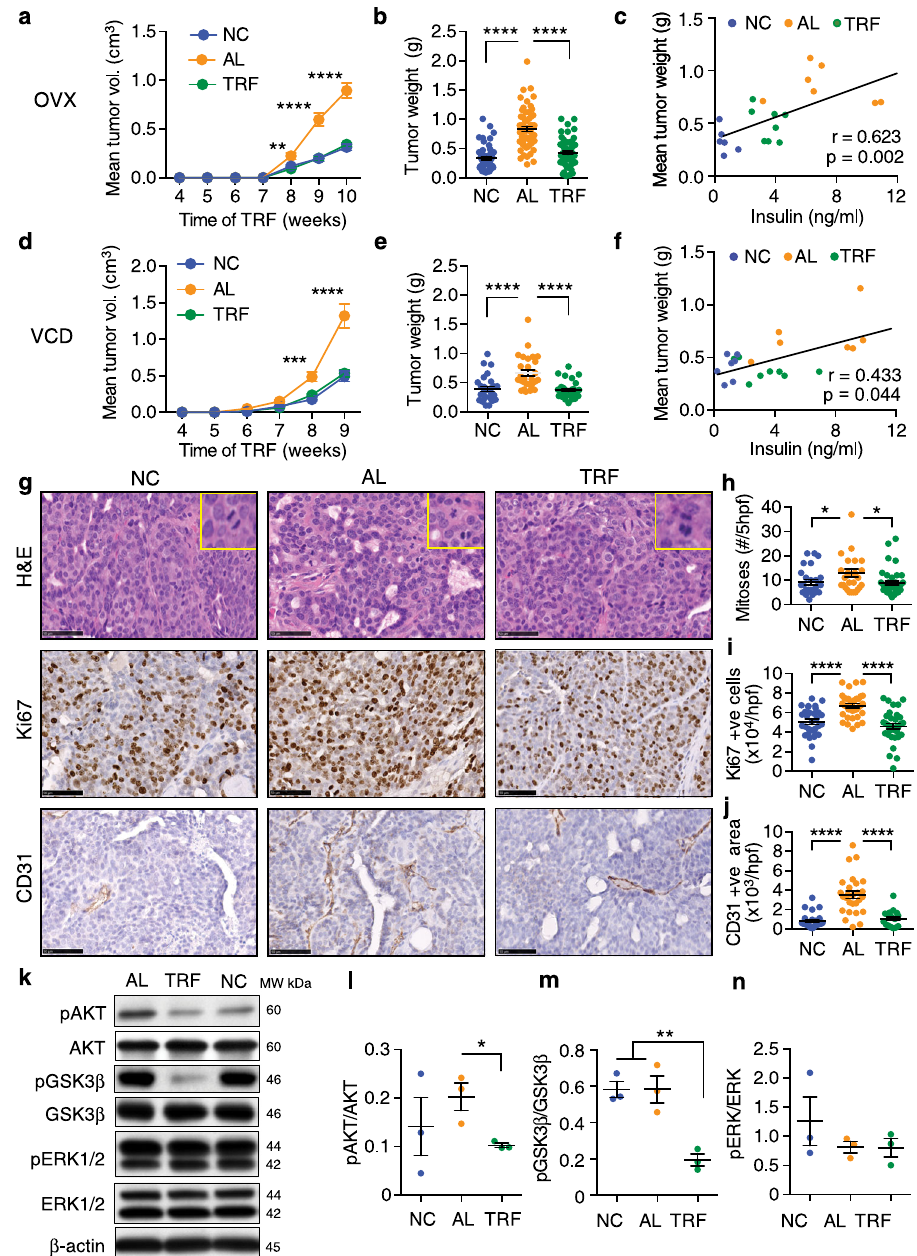
Fig. 2 TRF reduces Py230 mammary tumor growth in two obese postmenopausal mouse models. a , d Py230 tumor volume over time in OVX or VCD mice on NC, AL, and TRF (number of mice n = 8 for NC, n = 10 for AL, n = 10 for TRF in a ; n = 7 for NC, n = 7 for AL, n = 7 for TRF in d ; ** p < 0.01, *** p < 0.001, **** p < 0.0001 by two-way ANOVA with Tukey ’ s multiple comparisons test). b , e Individual tumor weights at the end of the study in OVX or VCD mice (number of tumors n = 32 for NC, n = 40 for AL, n = 40 for TRF in a ; n = 27 for NC, n = 28 for AL, n = 32 for TRF in d ; **** p < 0.0001 by one-way ANOVA with Tukey ’ s multiple comparisons test). c , f Correlation plot of mean tumor weight per mouse vs. fasting insulin in OVX or VCD mice (for c , number of mice n = 6 for NC, n = 7 for AL, n = 8 for TRF; for f , n = 7 for NC, n = 7 for AL, n = 8 for TRF). Data were analyzed by linear regression using Pearson correlation. g Representative H&E, Ki67 and CD31 staining of Py230 tumor tissue in OVX mice on NC, AL, and TRF. Scale bar, 50 µ m. Insets in H&E images show higher magni fi cation of a mitotic cell. Data shown are representative of two independent experiments. h – j Quanti fi cation of mitoses ( n = 27 for NC, n = 38 for AL, n = 36 for TRF), Ki67-positive cells ( n = 31 for NC, n = 36 for AL, n = 32 for TRF), and CD31 staining ( n = 27 for NC, n = 27 for AL, n = 21 for TRF). Data are presented as mean ± SEM per high-powered fi eld (hpf) or 5hpf for mitoses, with 4 hpf per section ( n = number of tumors). Asterisks indicate signi fi cance; * p < 0.05, **** p < 0.0001 by one-way ANOVA with Tukey ’ s multiple comparisons test. k Akt(Ser473), GSK3 β (Ser9), and ERK(Thr202/Tyr204) phosphorylation by western blot in Py230 tumor extracts. l – n Quanti fi cation of Akt, GSK3 β , and ERK phosphorylation normalized to total protein (mean ± SEM, n = 3, two-tailed t test). Data are presented as mean ± SEM. Asterisks show statistical signi fi cance TRF vs AL or as shown.